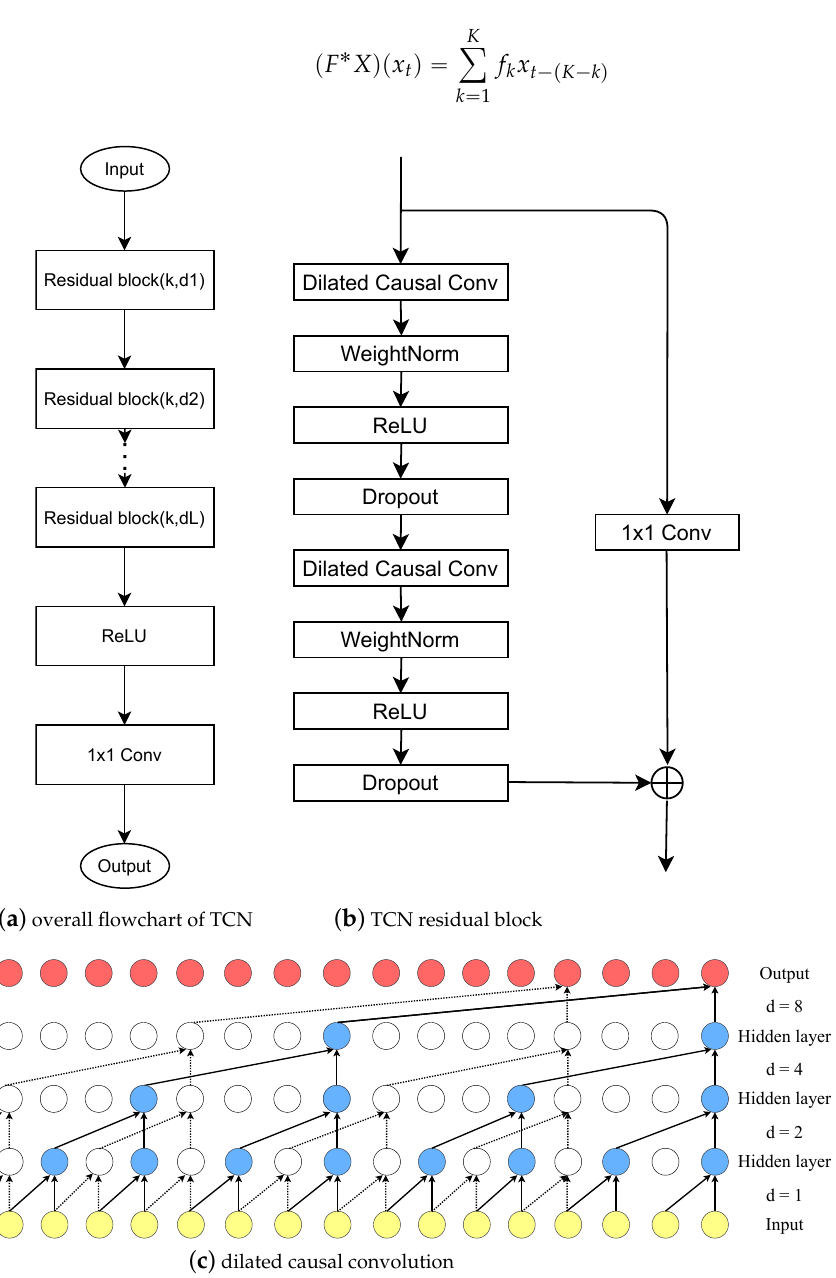
Figure 2. Construction of TCN. ( a ) Overall flowchart of TCN. ( b ) TCN residual block. The residual block is stacked in two layers, and each layer is composed of dilated causal convolution and nonlinear layers. ( c ) A dilated causal convolution with dilation factors d “ r 1,2,4,8 s and filter size k “ 2. The receptive field expands with the increase of d and k which means that more of the input sequence is